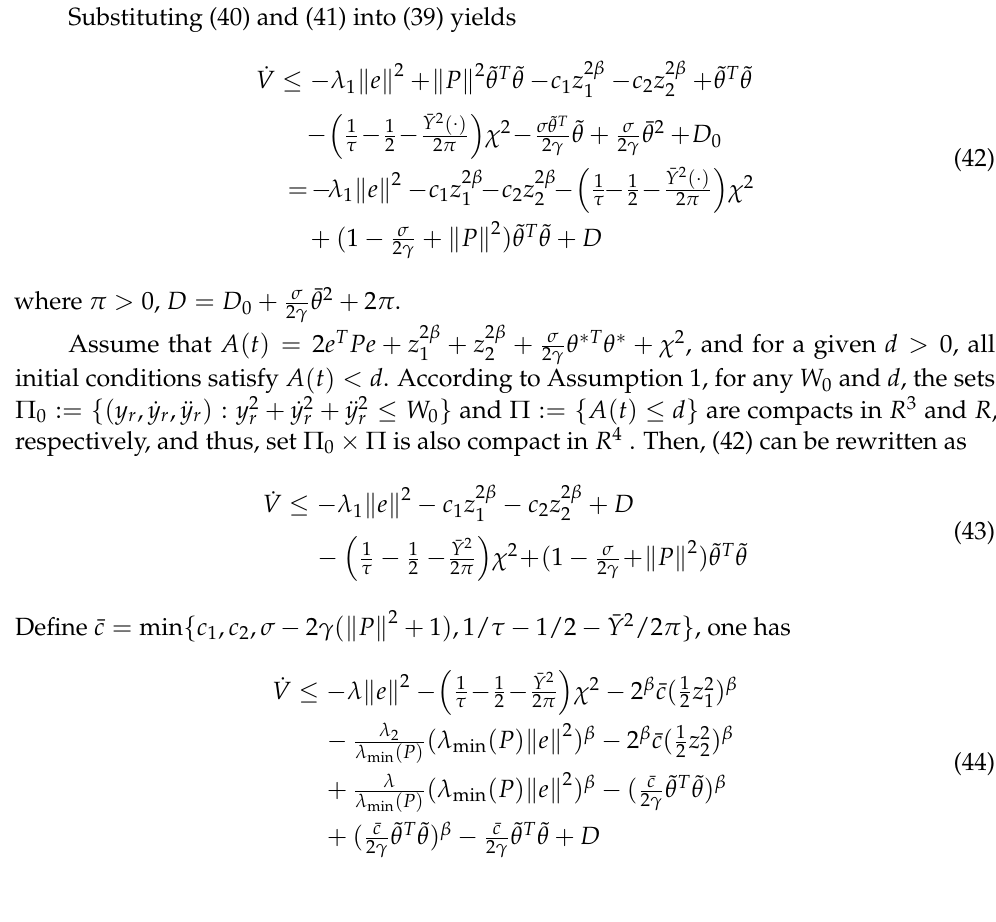
Figure 2. The graph of the above control